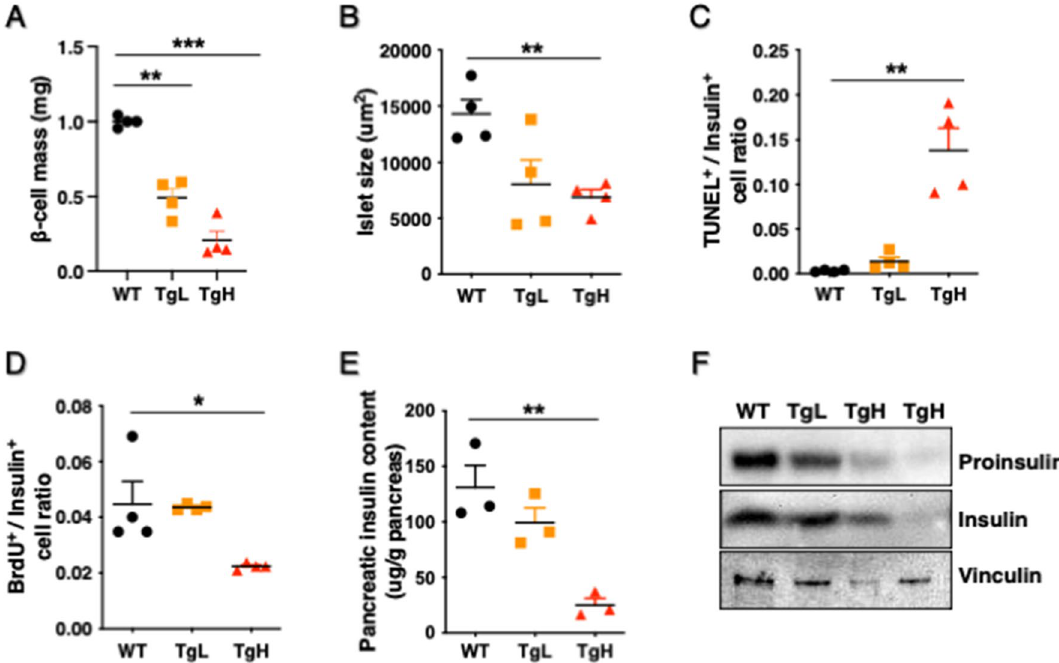
Figure 3. Overexpression of miR-30d significantly induced β-cell apoptosis in TgH mice. (A) Pancreas sections were immunostained with anti-insulin. The islet area and the area of each section was determined with the ImagePro image software. β-cell mass (mg) was calculated by multiplying the ratio of insulin-positive areas by pancreatic weight (n = 4 per group). ( B ) Islet size was calculated by dividing the area of insulin-positive islets by the total islet numbers (n = 4 per group). ( C ) Sections were performed in situ TUNEL assay, followed by staining with anti-insulin and DAPI. The percentage of TUNEL-positive β-cells was calculated and divided by total number of insulin positive cells. At least 2000 β-cell nuclei were counted per pancreas (n = 4 per group). ( D ) BrdU (100 μg/g body weight) was administrated for 7 consecutive days through i.p. injection in HFD mice at 20-week-old. Pancreas sections were stained with anti-BrdU and subsequently with anti-insulin. The percentage of BrdU-positive β-cells was calculated and divided by total number of insulin-positive cells. At least 2000 β-cell nuclei were counted per pancreas (n = 4 per group). ( E ) Whole pancreas tissues were collected from mice at 20-week-old and homogenized in acid ethanol. Insulin content was measured and normalized to the pancreas weight (n = 3 per group). ( F ) Western blots confirmed that both proinsulin and mature insulin protein levels were reduced in islets isolated from TgH mice compared to TgL and WT mice. Islets were lysed and analyzed by immunoblotting with anti-proinsulin, anti-insulin, and anti-Vinculin (loading control). All data were presented as mean ± SEM. * p < 0.05, ** p < 0.01, or *** p < 0.001 versus